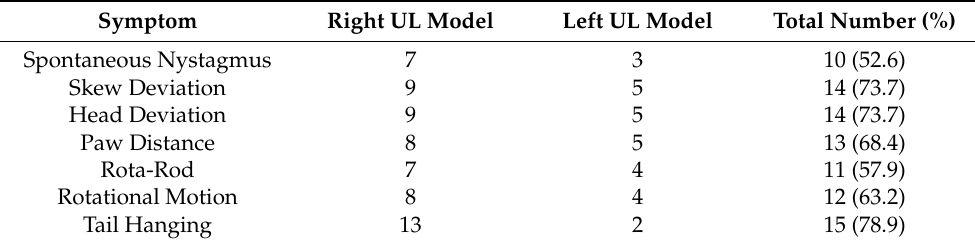
Table 1. The number of animals for each symptom in the right and left UL